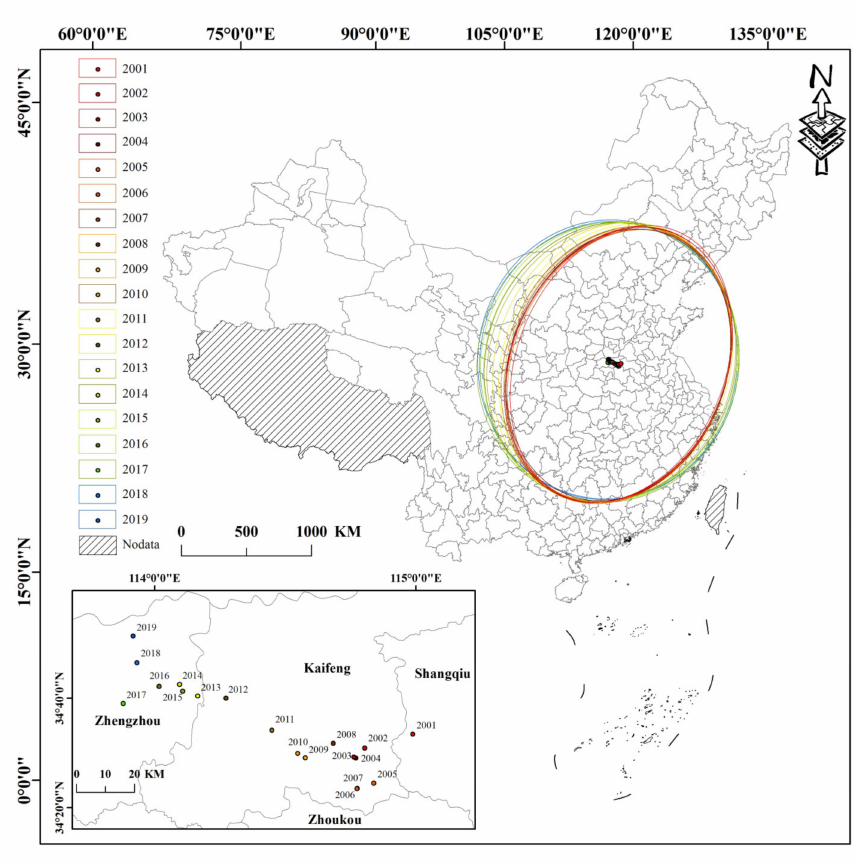
Figure 9. Ellipse analysis of China (cid:48) s carbon emission standard deviation from 2001 to 2019.